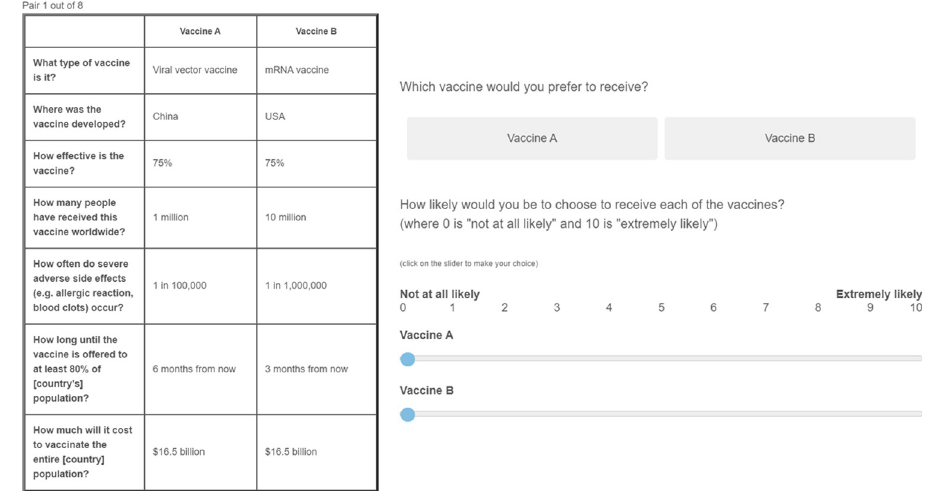
Fig 1. Screen shot of a vaccine decision scenario (translated into English). Before being exposed to eight vaccine decision scenarios, respondents were exposed to (1) general information about vaccines, and (2) descriptions of the different vaccine types (see Supporting